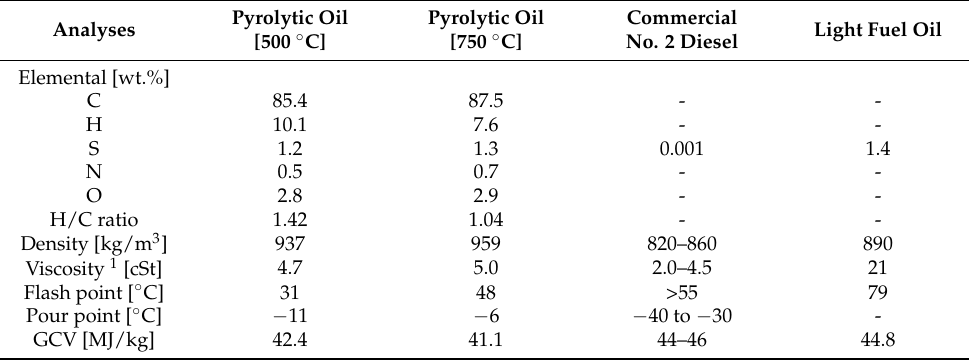
Table 5. Characteristics of pyrolytic oil compared to diesel fuel and fuel oil.